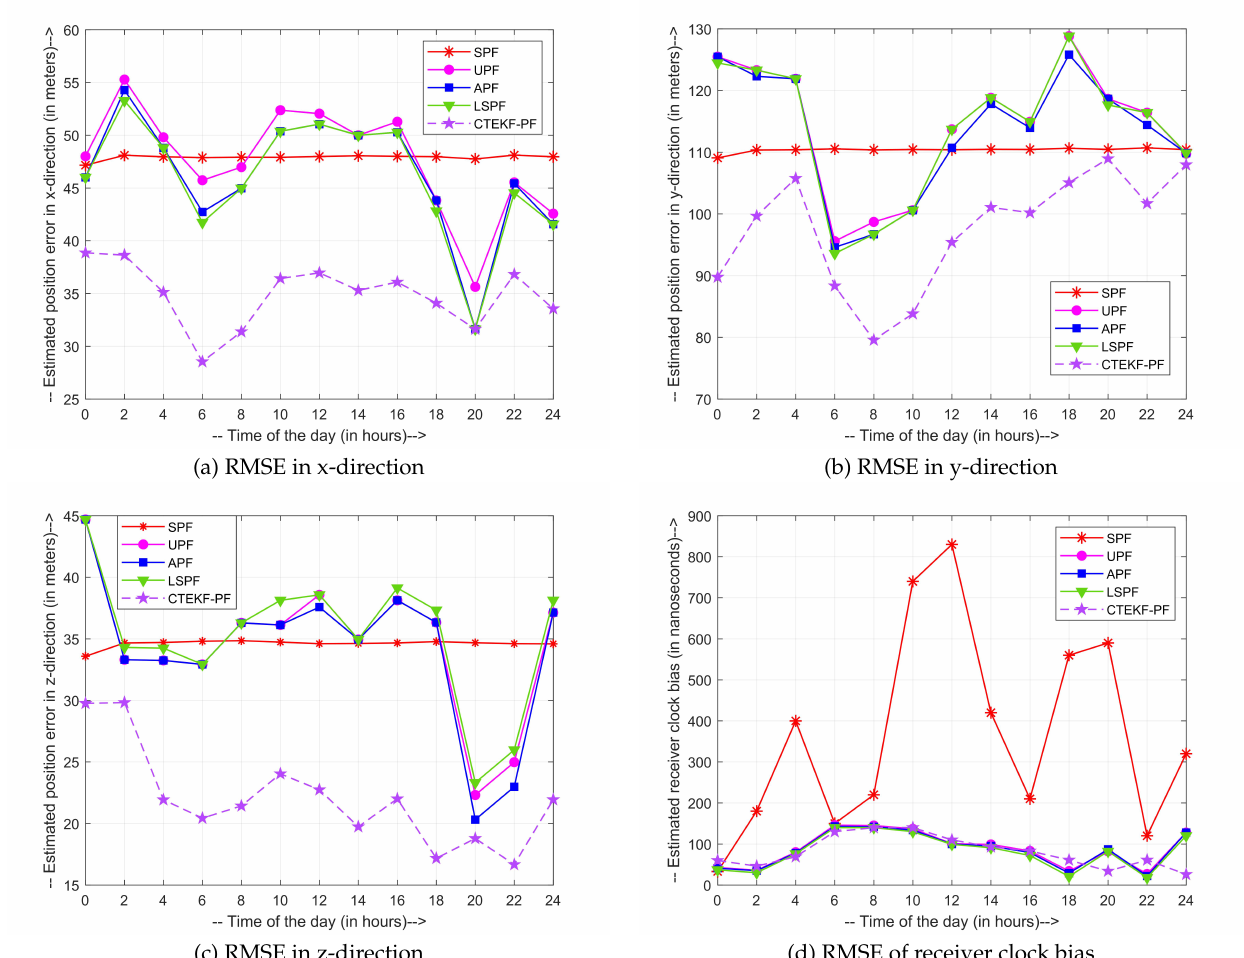
Fig. 3. Comparison of estimated RMS position error and receiver clock bias.